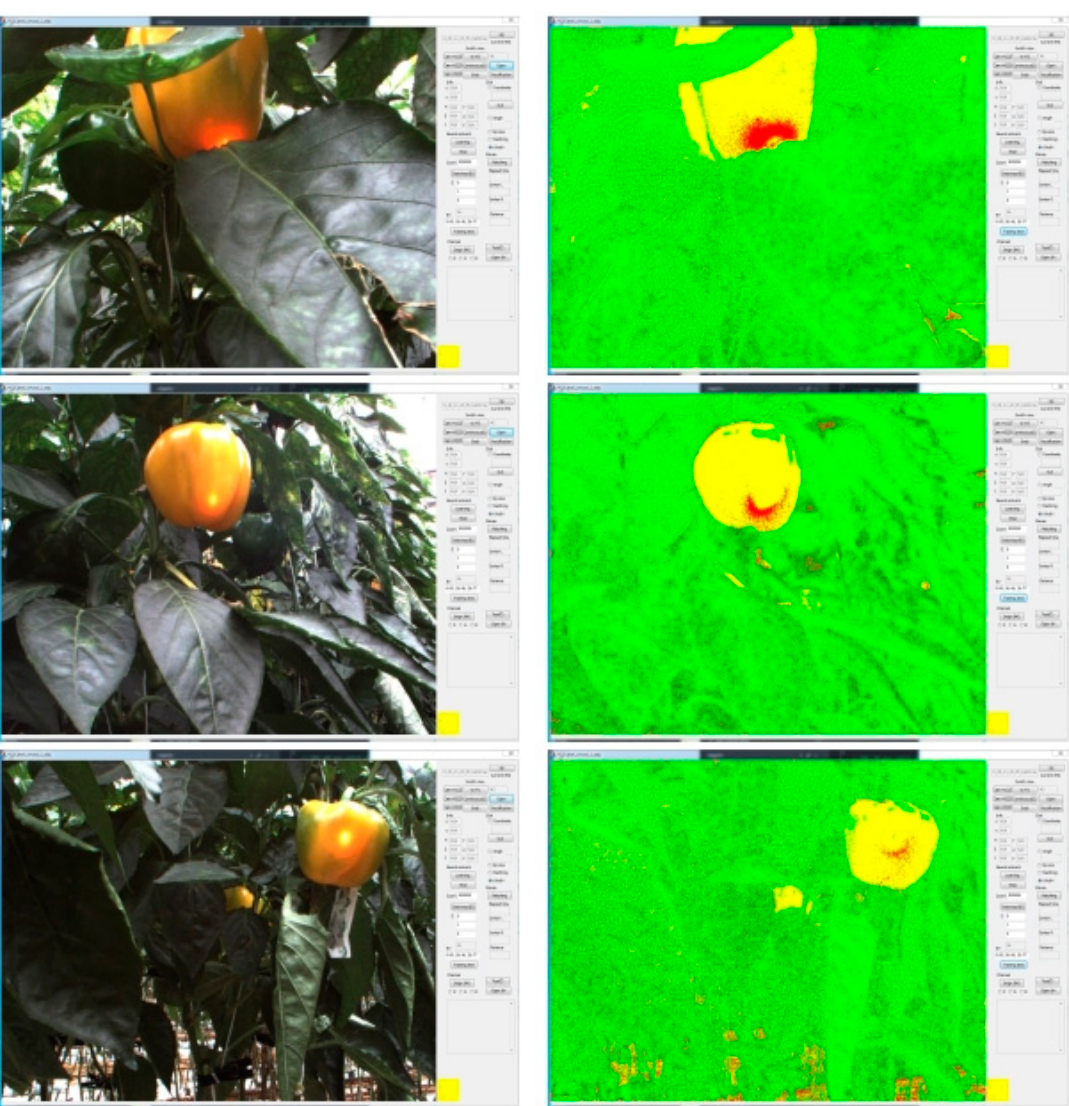
Figure 17. Activation images using the backpropagation algorithm (yellow sweet pepper).